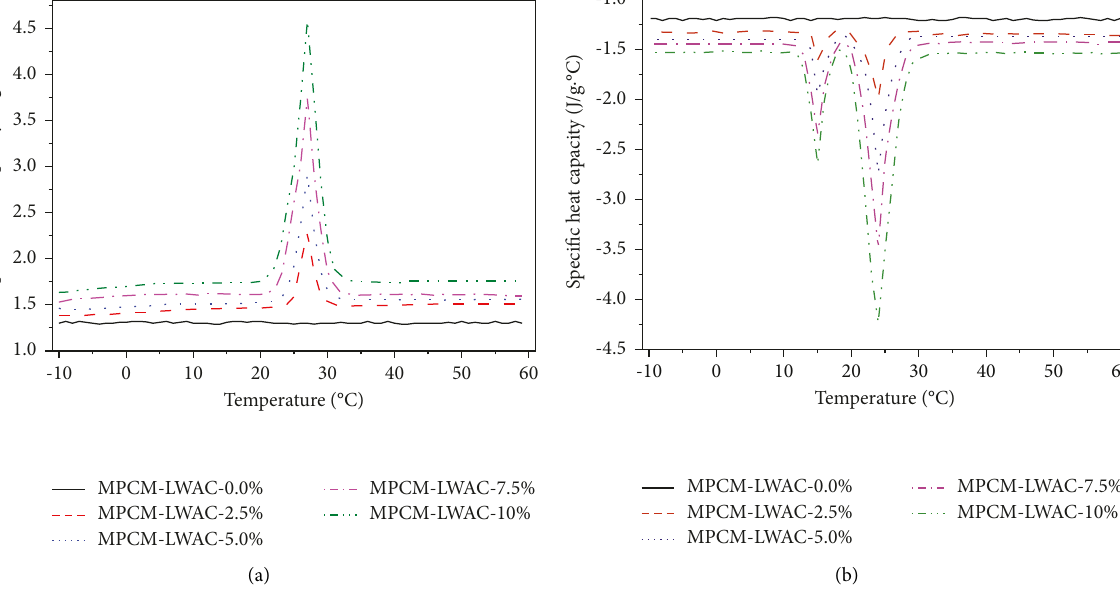
Figure 12: Curve of specific heat capacity of MPCM-LWAC with temperature. (a) Heat absorption by melting. (b) Heat release by